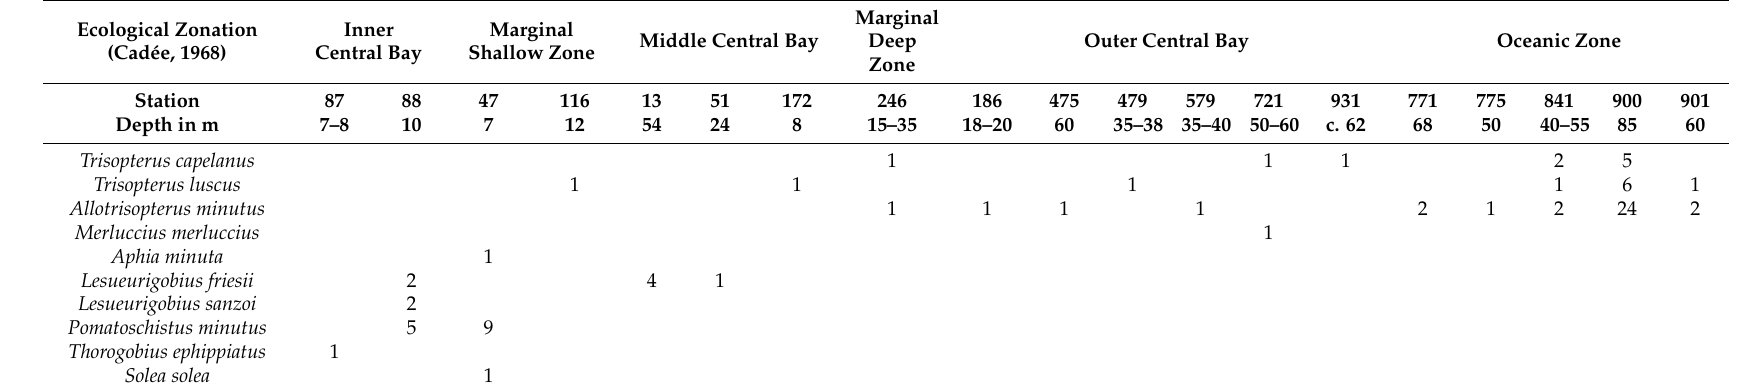
Table 6. Distribution of otoliths in sea-bottom samples in the Ría de Arosa, Galicia, northwestern Spain. Ecological Zonation (Cadée,